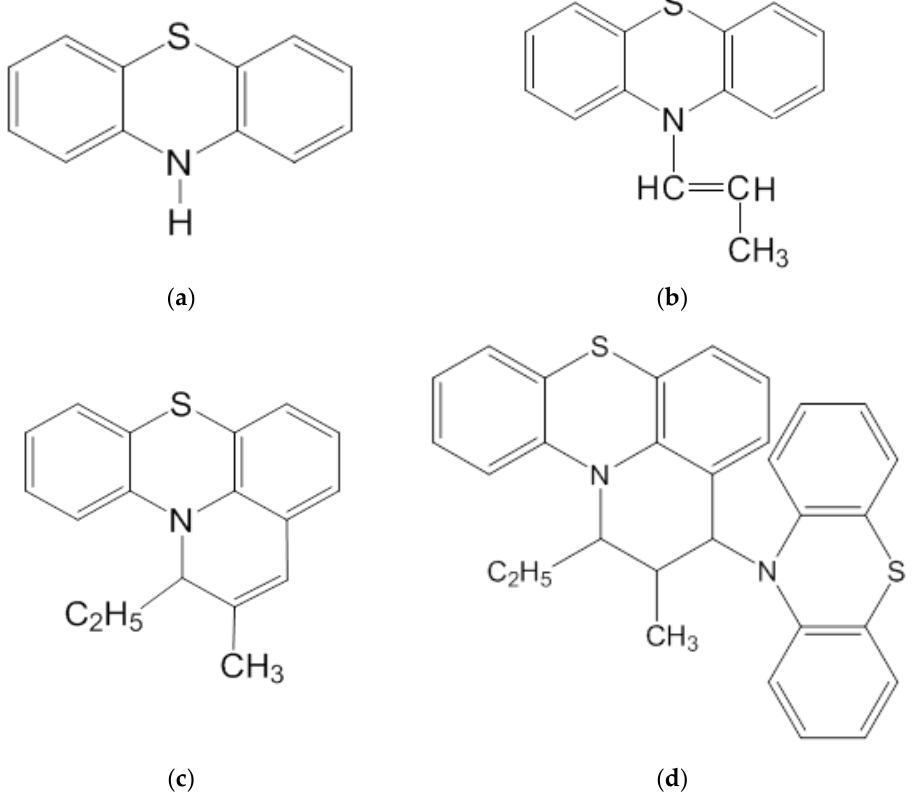
Figure 1. Structural formulas of phenothiazine and its derivatives: ( a ) phenothiazine (PT); ( b ) cis-10-propenylphenothiazine(cis-10-PPT); ( c ) 2-methyl-1-ethyl-1H-pyrido-[3,2,1-k,l]-phenothiazine. Pyridophenothiazine (PyrPT); ( d ) 2-methyl-1-ethyl-3-(10-phenothiazinyl)-2,3-dihydro-1H-pyrido-[3,2,1-k,l]phenothiazine. Propenylphenothiazine dimer (DP Р T).